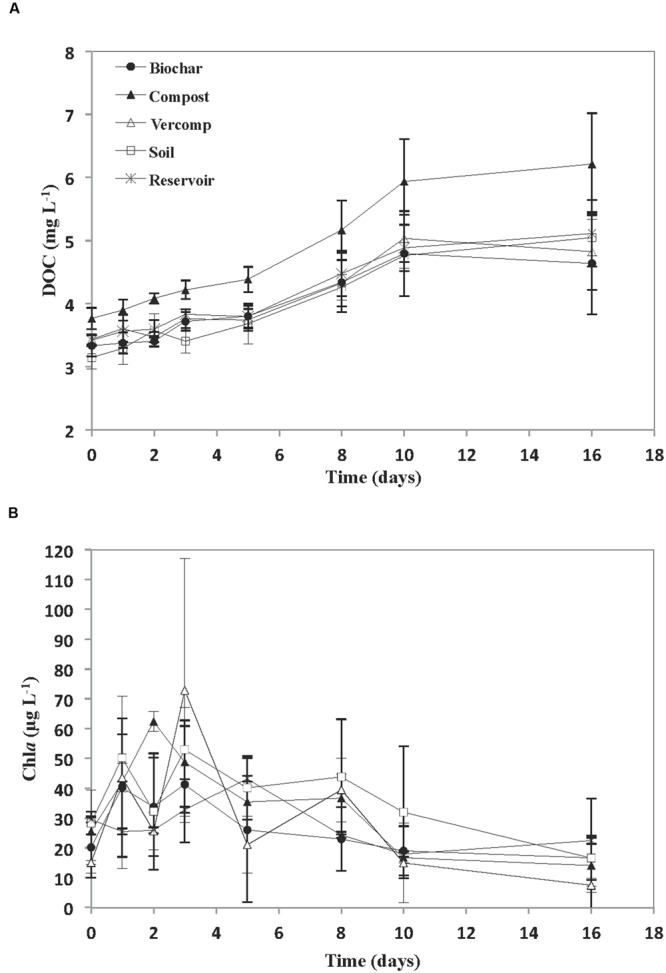
(A) Concentration of DOC (mg L-1) and (B) Chla (μg L-1) for each treatment. The mean and standard deviation is given for each treatment (n = 3).